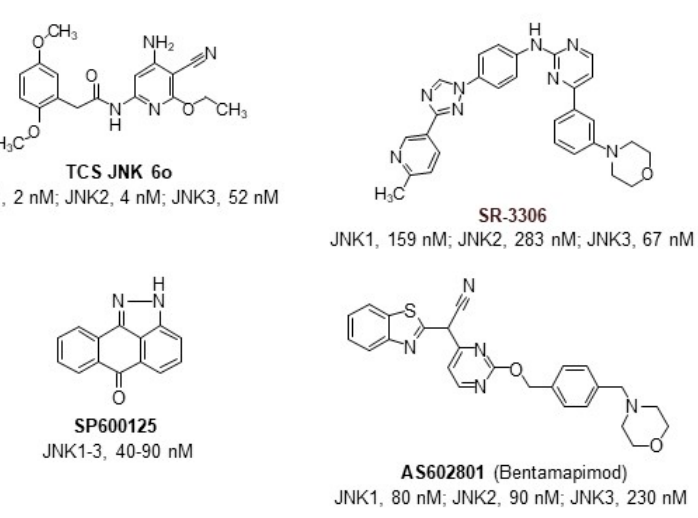
Figure 1. The reported scaffolds of JNK inhibitors and range of their inhibitory activity (IC 50 values) [25,32–34].